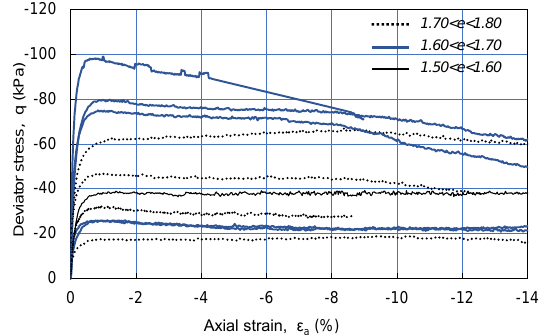
Figure 7. Stress-strain curves in extension tests (CIU_e).